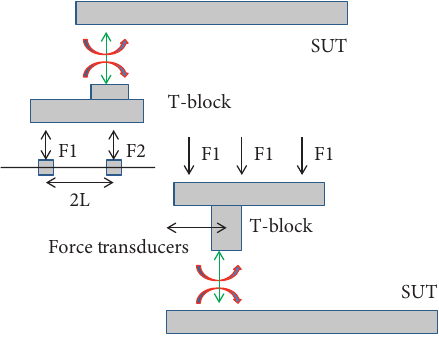
Figure 7: Method of applying bending